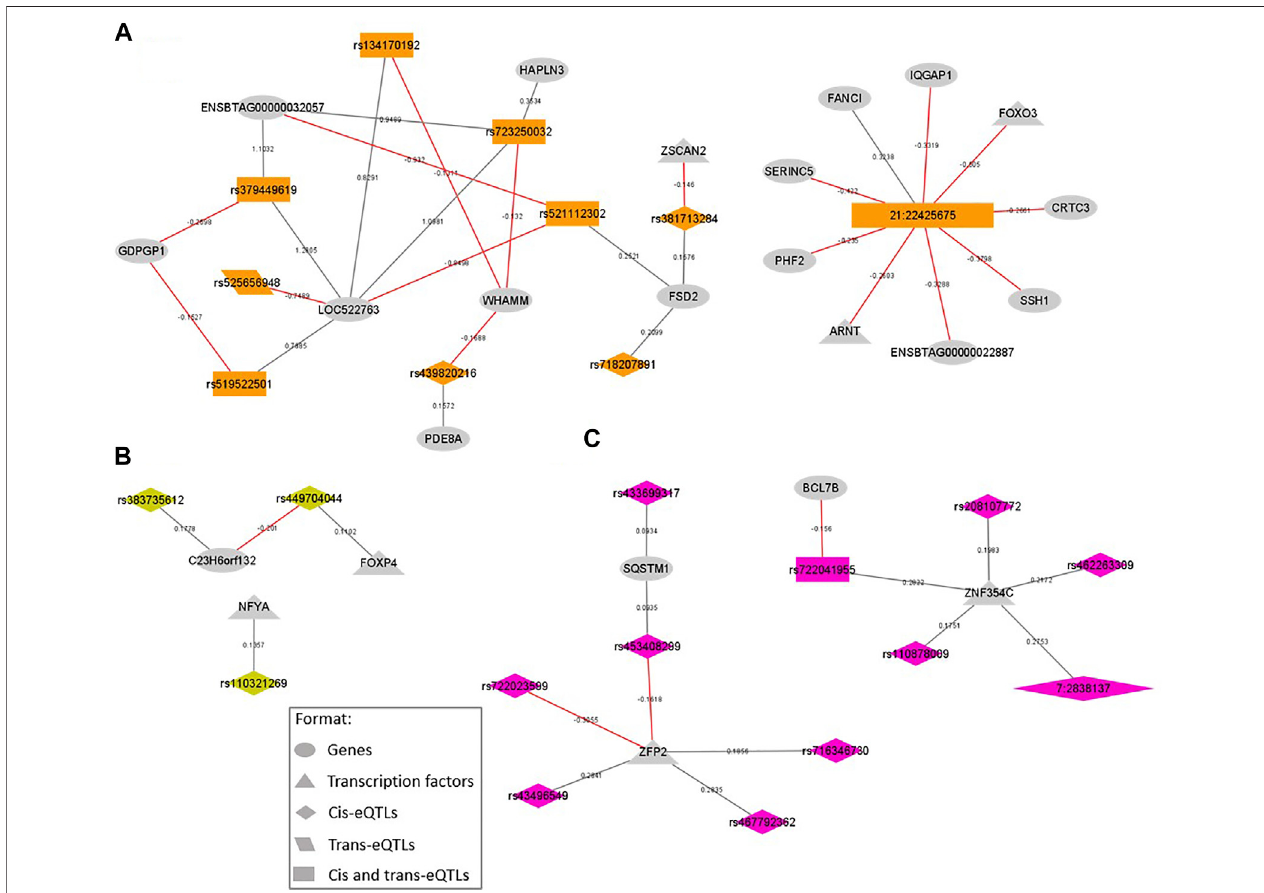
FIGURE 3 | SNP-gene regulation networks representing the eQTL variants located within QTL windows associated with intramuscular fat content (IMF) and the genes regulated by them, focusing on the variants regulating transcription factors (TFs) and their direct connections. The colors are coded by QTL window: (A) BTA21_22, eQTL represented in orange; (B) BTA23_15, eQTL represented in lightgreen; (C) BTA7_2, eQTL represented in pink. All the formats are described in the legend. New variants are represented by chromosome: position. Gray lines represent a positive beta-value and red ones represent a negative beta-value.